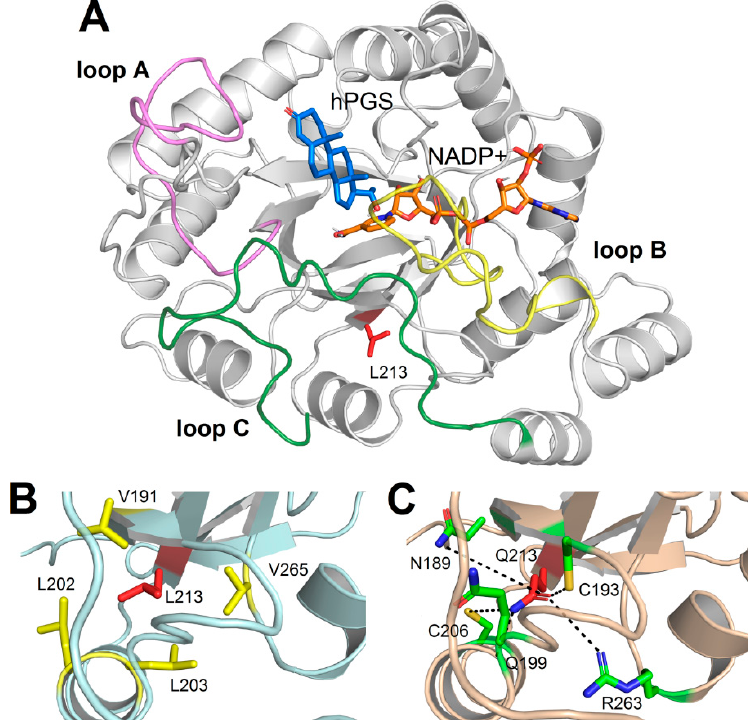
Figure 3. ( A ) Three-dimensional structure of AKR1C1 complexed with NADP+ and hPGS. Protein structure is shown as grey cartoon, loop A is colored in violet, loop B in yellow, and loop C in green. Residue L213, NADP+, and hPGS are represented as sticks and colored in red, orange, and blue, respectively; O atoms are depicted in red, N atoms in blue, and H atoms in white. For the sake of clarity, only non-polar H atoms are shown; ( B ) Detail of the residues involved in hydrophobic interactions with L213. Protein structure is shown as light blue cartoon; residues are shown as sticks; L213 is shown in red; V191, L202, L203, and V265 are shown in yellow; ( C ) Detail of the residues involved in hydrogen bonds with Q213. Protein structure is shown as light orange cartoon; residues are shown as sticks; Q213 is shown in red; N189, C193, Q199, C206 and R263 are shown in green. O atoms are colored in red, N atoms in blue, and S atoms in yellow, hydrogen bonds are shown as dashed lines. Please note that distances between H-bond donors and acceptors and geometric features are merely representative, as the figure represents a single frame out of 100,000 frames spanned by MD simulations.